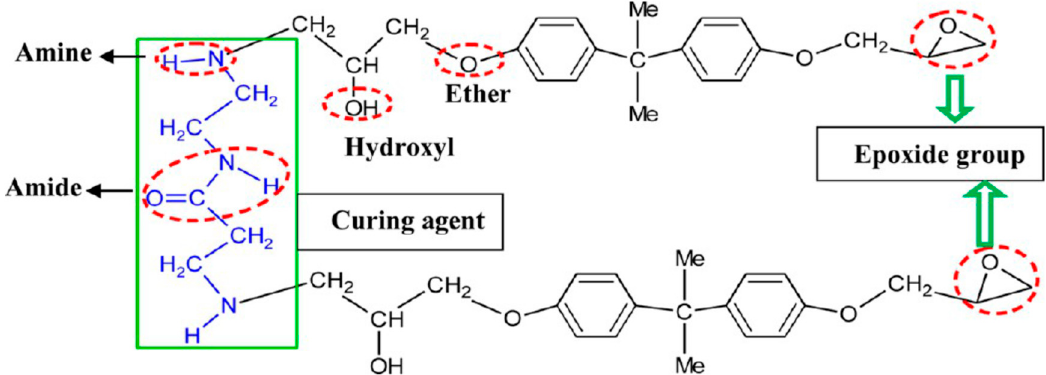
Figure 6. Chemical structure of aminoamide cross-linked DGEBA (Diglycidyl ether of bis phenol A) epoxy resin. The functional groups are encircled by red dotted lines.